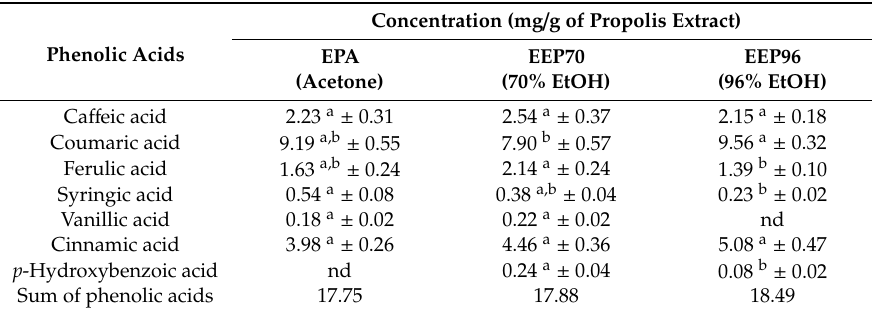
Table 2. Concentrations of phenolic acids in propolis